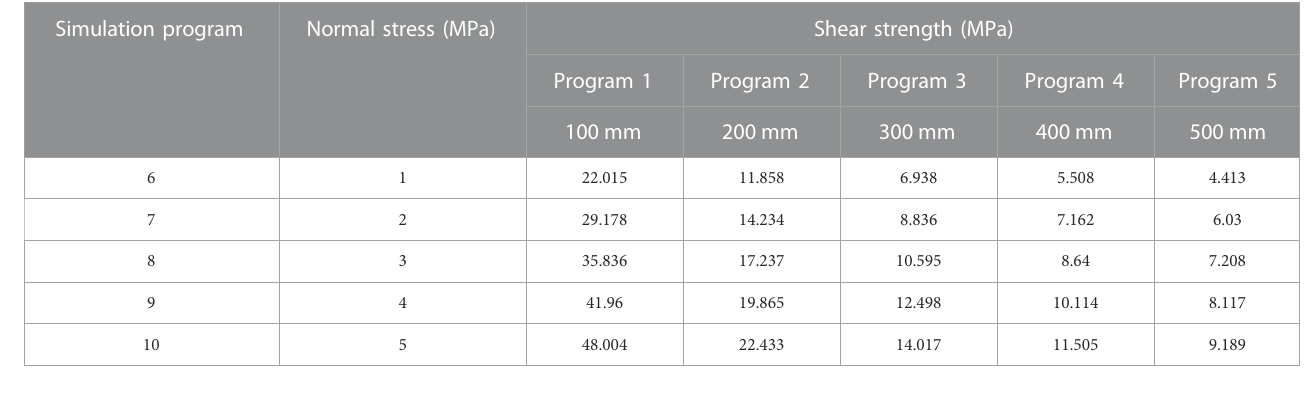
TABLE 6 Shear strengths.